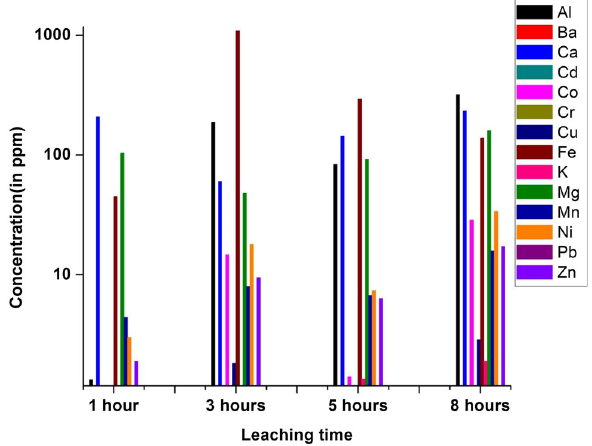
Fig. 28 Change in elemental concentration (in ppm) in aqueous leachates of Ledo coal (LC-60A) with leaching time (in hour) at 65 (cid:3) C